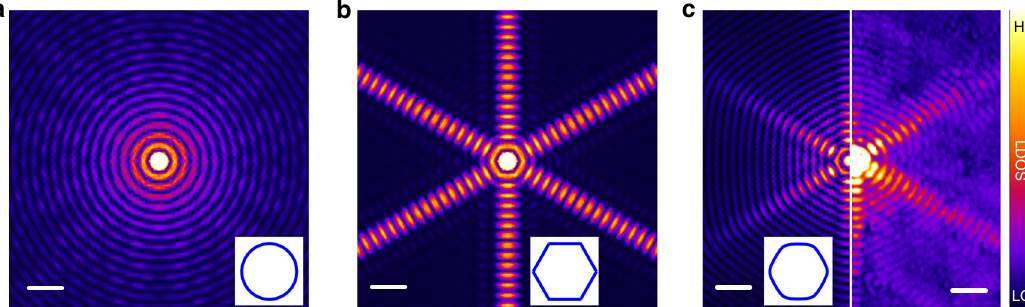
Fig. 3 In fl uence of the shape of the Fermi surface on the focusing of Yu – Shiba – Rusinov bound states. a , b Numerically calculated LDOS maps around a single magnetic impurity for the hole-like YSR bound state considering a a circular and b a hexagonal Fermi surface (FS). c Direct comparison between the calculated LDOS with the realistic FS of La(0001) (left) and the experimentally obtained dI / dV map at E = − E YSR (right). Scale bar: 10 atomic sites (simulations), 4.0 nm (experiment). For details of the model and the calculation parameters, see Methods, Supplementary Notes 5 and 6, Supplementary Figs. 5 and 6. The corresponding shapes of the FS are depicted in the inset for each calculated image. The intensity scale of all calculated LDOS maps is the same, to be able to compare them directly with